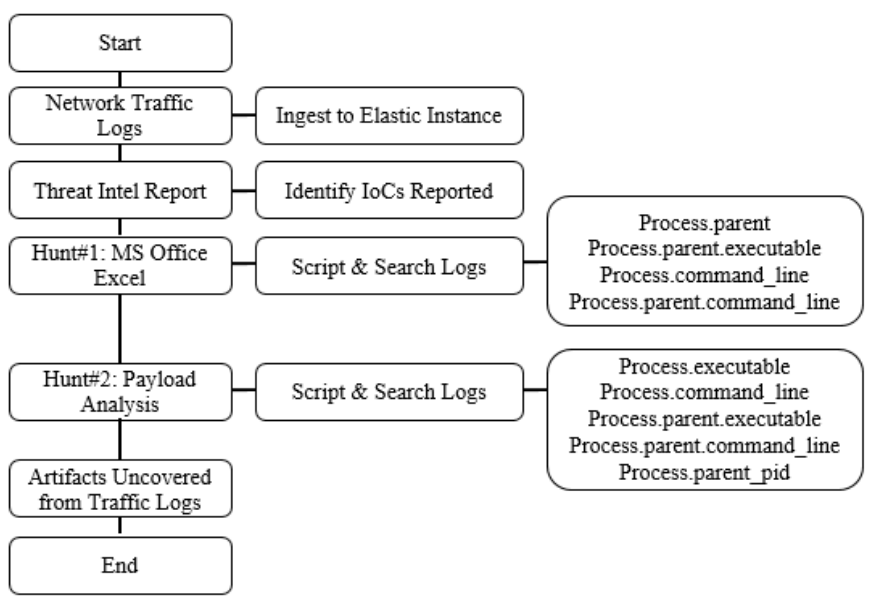
Figure 16. Threat hunting workflow.